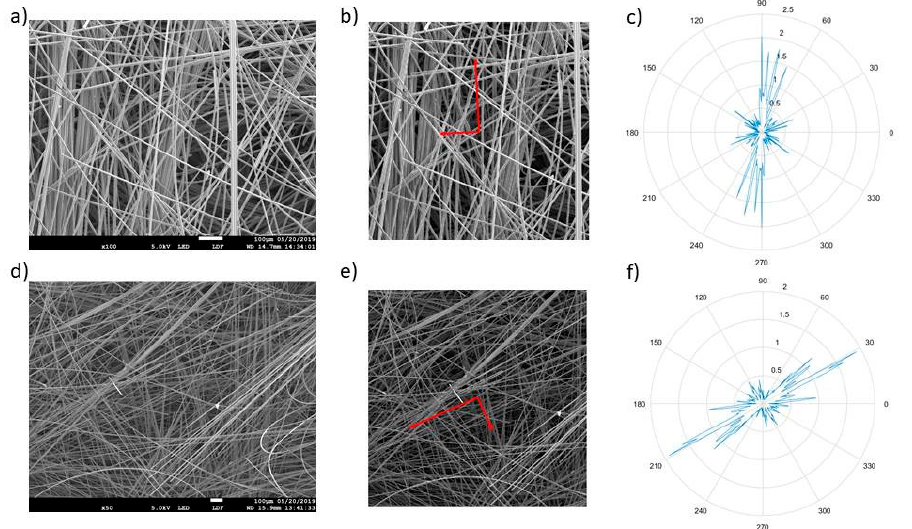
Figure 5. Example of the captured SEM micrograph at ×100 and ×50 magnification ( a , d , respectively), analysed image with two sketched eigenvectors ( b , e ), and polar plot distribution of the fibre orientation ( c , f ) at both magnifications, ×100 and ×50, respectively.